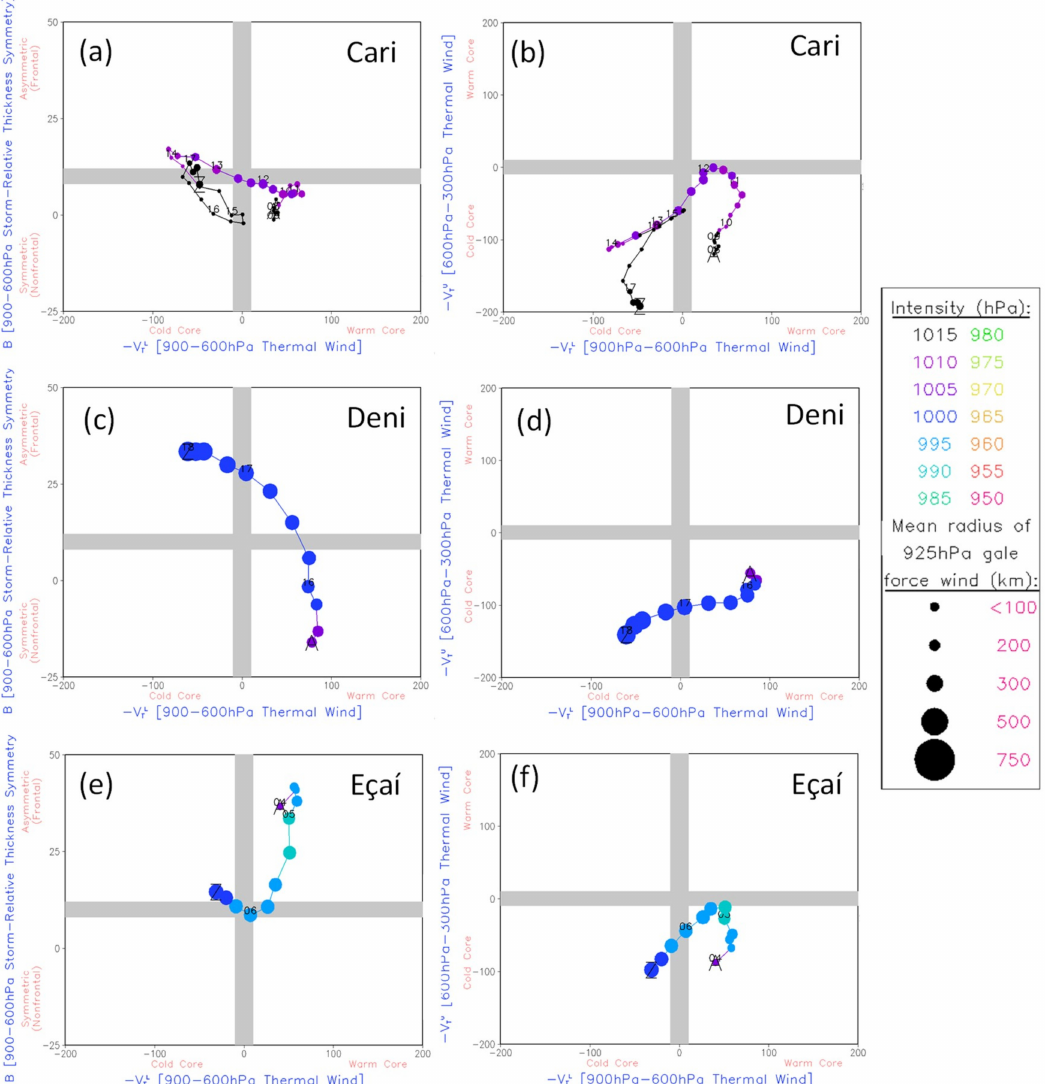
Figure 3. CPS of Cari, Deni, and Eça í . ( a , c , e ): the left column presents the parameters B versus –V TL ; ( b , d , f ): the right column the parameters –V TL versus –V TU . A and Z indicate, respectively, the first and the last time of the cyclone lifecycle. The circle size indicates the mean radius of the wind gale force at 925 hPa (17 m · s − 1 ) and the colors are the sea-level pressure values (see scale in the right of figure). Positions at 0000 Z are labeled with the